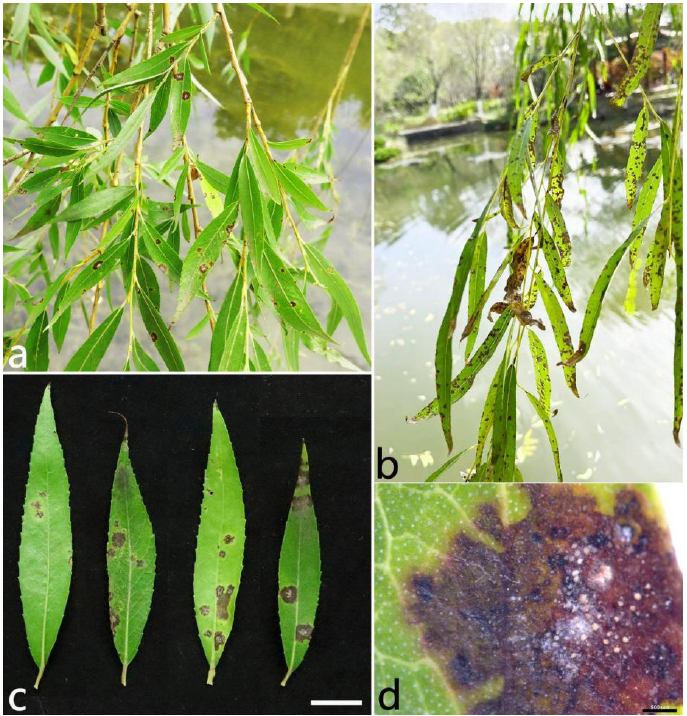
Figure 1. Symptoms of Salix babylonica anthracnose in the field. ( a – c ) Diseased leaves infected natu- rally. ( d ) Orange conidial masses after the leaves were incubated for 24 h under moist conditions. Scale bars: ( c ) = 1 cm; ( d ) = 500 µm.